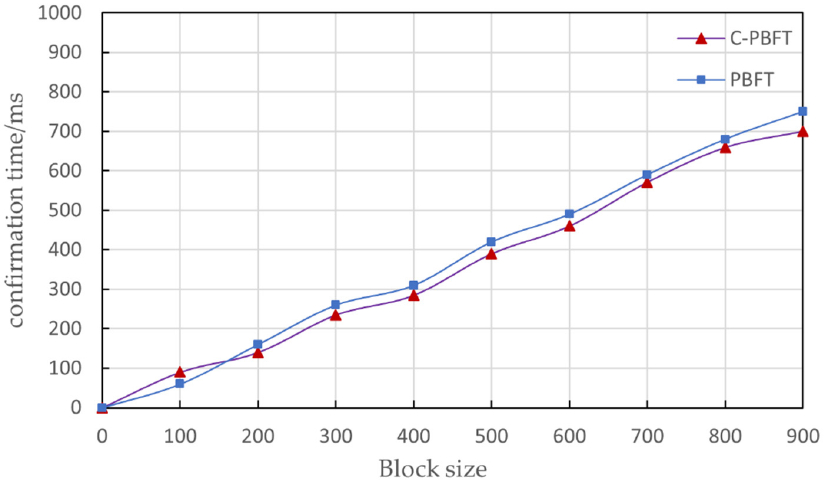
Figure 4. Different block delays.